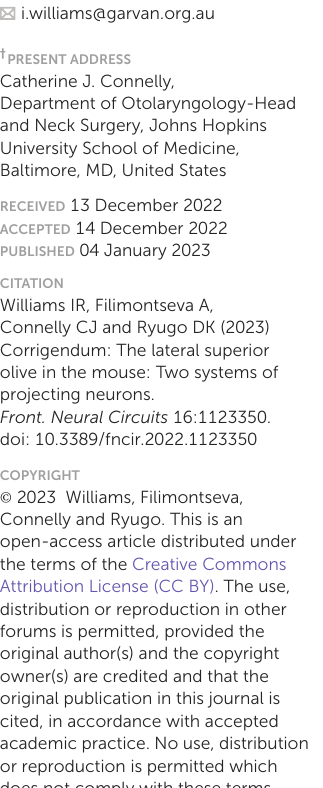
Figure 1. Retrogradely labeled LSO principal neurons from unilateral and bilateral tracer injections into the CNIC. (A) A unilateral injection of a retrograde tracer into the CNIC resulted in bilateral labeling of LSO principal neurons. Schematic representation of FluoroGold (FG) injected into the CNIC to label the neurons in the LSO with ascending projections. Photomicrographs (20x objective) of the ipsilateral and contralateral LSO showing FG-labeled principal neurons. Gray arrowheads: PO neurons on the borders of the LSO. (B) Schematic illustration of the retrograde tracers FG (yellow) and FD (green) injected into the right and left IC, respectively (same animal), to label the principal neurons in the LSO. Photomicrographs (20x objective) of the ipsilateral and contralateral LSO showing FG and FD labeled principal neurons in the same nucleus. Gray arrowheads : PO neurons on the borders of the LSO. (C) Photomicrographs (100x objective) of the ipsilateral (top row) and contralateral (middle row) principal cells labeled from chromogenic development of FG with DAB (brown) or NiDAB (black) and fluorescent tracers (FD-green, FG-yellow, Antionia Red-magenta). The principal neurons were fusiform with unipolar or bipolar dendritic extensions. The preolivary neurons were also labeled (bottom row) and featured a large, polygonal cell body